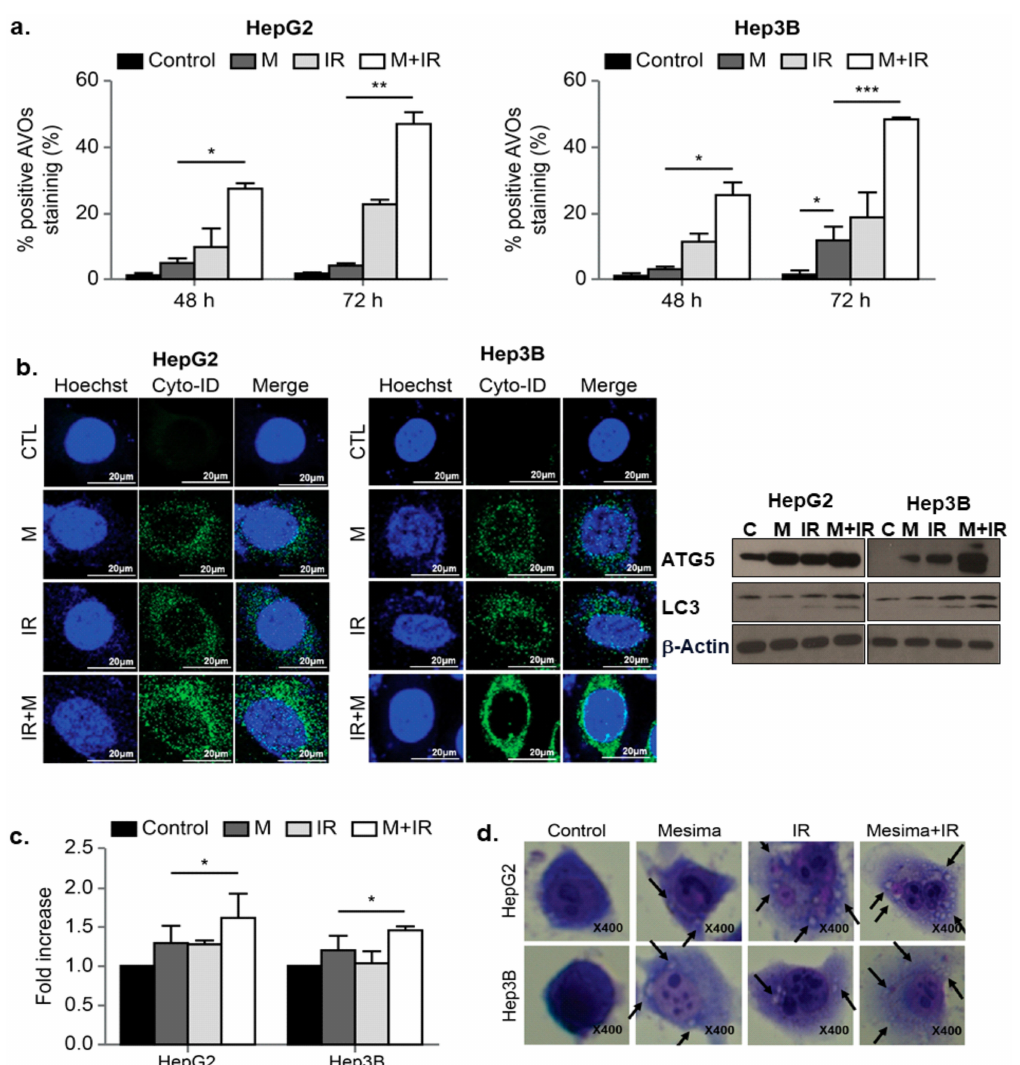
Figure 3. E ff ects of mesima and radiation on autophagy. ( a ) Development of acidic vesicular organelles (AVOs) in mesima and radiation-treated HepG2 and Hep3B cells. Green and red fluorescence in acridine orange (AO)-stained cells were detected using flow cytometry; * p < 0.05; ** p < 0.01; *** p < 0.001. ( b ) (left) Cyto-ID staining with and without mesima and radiation treatment in the two HCC cell lines; (right) immunoblotting of cell lysates with the indicated antibodies. ( c ) Mesima + radiation resulted in an increase in the CYTO-ID dye signal; * p < 0.05. ( d ) Cells were stained with Giemsa (10% in phosphate-bu ff ered saline), washed, and imaged under a Leica DM IRB light microscope (magnification, 40 × ). Black arrows show vacuoles. A representative of two independent experiments is